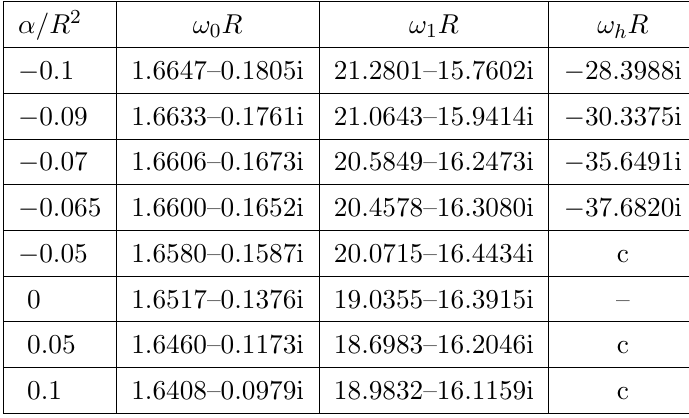
Table 2 . Quasinormal modes of the Gauss-Bonnet-AdS black hole: D = 5, scalar channel, ‘ = 2, r H =R = 6. The frequencies are: ! 0 is the fundamental sound mode, ! 1 is the branch of modes with spacing linear in r H =R , ! h is the lowest mode on the imaginary